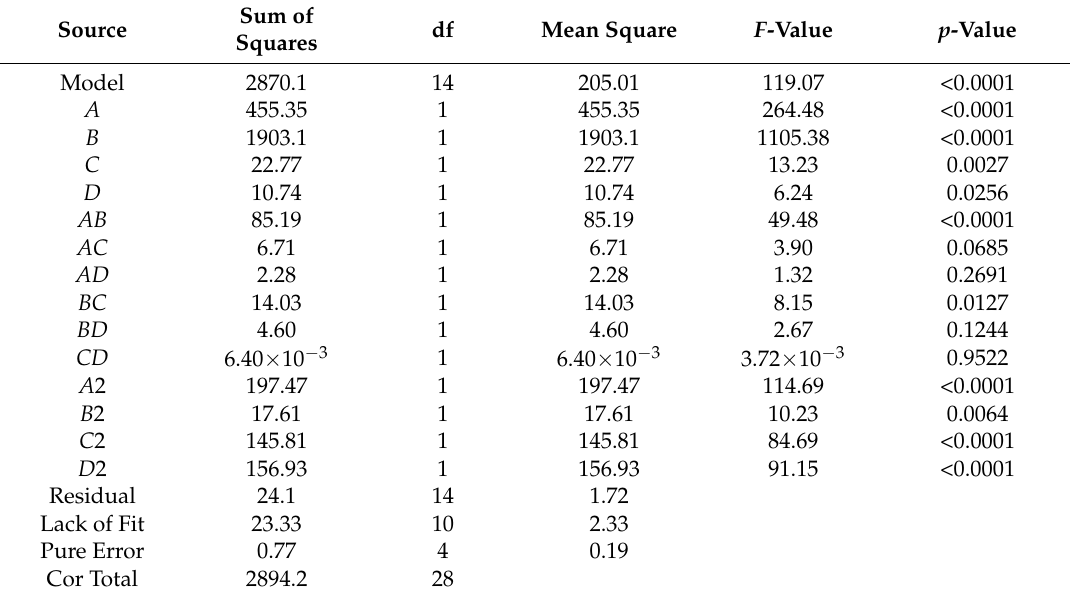
Table 3. Pareto analysis of variance (ANOVA) of the second-order polynomial